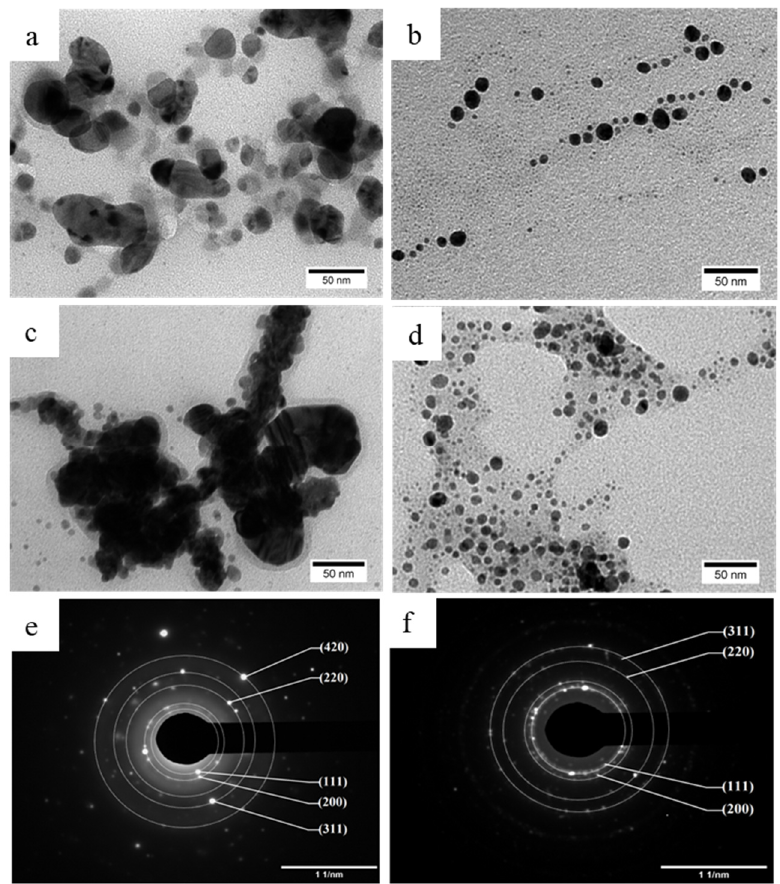
Figure 5. TEM images of the resulting AgNPs from colloidal samples: ( a ) Baked 1, ( b ) Baked 10, ( c ) Baked 100 and ( d ) Unbaked 10. Selected area electron diffraction (SAED) results of: ( e ) Baked 10 and ( f ) Unbaked 10 samples.